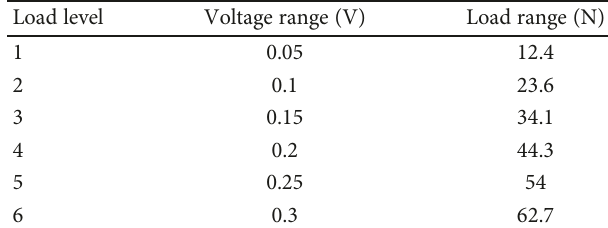
Figure 41: D2, node 93 acceleration, FFT, full model.